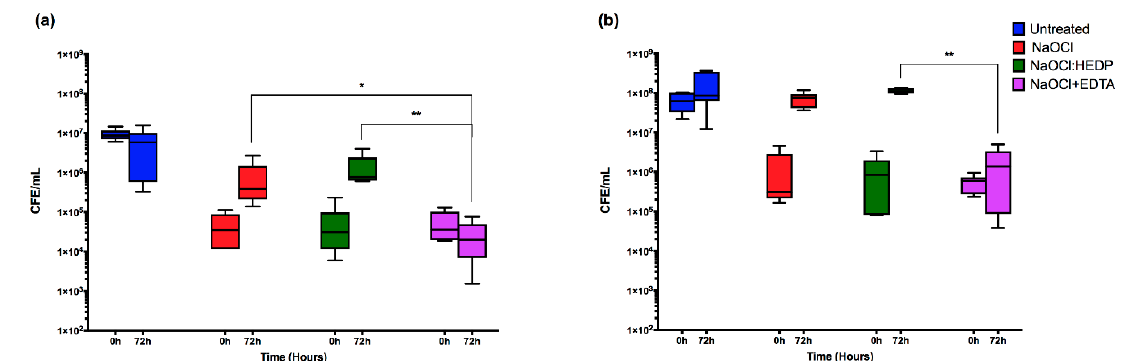
Figure 1. The effect of the three endodontic irrigants on pre-formed 24 h mono-species biofilms. NaOCl alone, NaOCl:HEDP and NaOCl+EDTA were used to treat ( a ) C. albicans and ( b ) E. faecalis . CFE at 0 h and 72 h are presented as box and whisker plot of each treatment on log 10 Y axis. Statistical significance between the three treatment conditions at 72 h was presented as * p < 0.05, ** p < 0.01. Results represent data from three independent experiments.